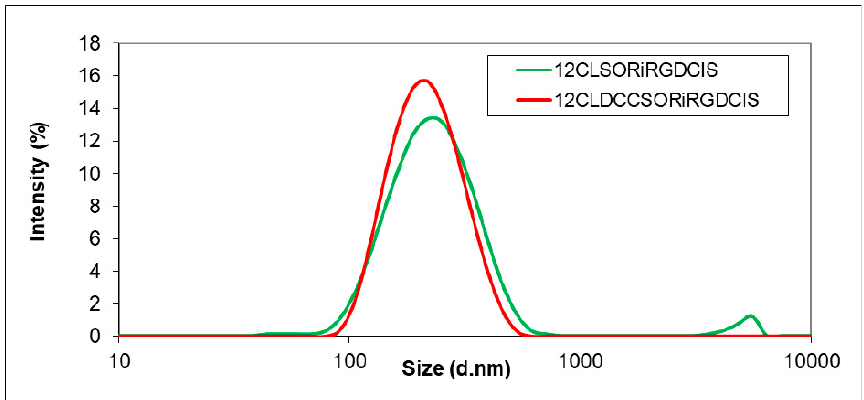
Figure 4. Particle size distribution of dual drug and iRGD-loaded nanoparticles with (DCCSORiRGDCIS) and without DCC (SORiRGDCIS).